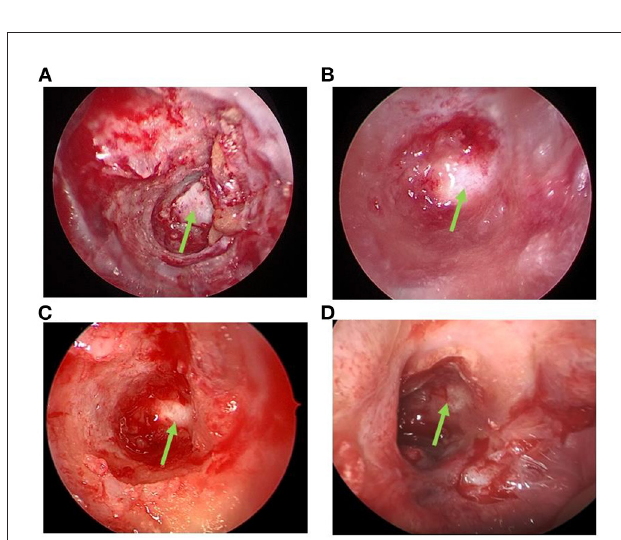
FIGURE2 Green arrow: The optic nerve. (A) Immediately after decompression: The optic nerve was exposed, and the decompression was sufficient. (B) After dressing change 1 week after surgery: Sphenoid sinus and ethmoid sinus were cleaned, secretion was removed by suction, nasopore was filled beside the optic nerve, and 30 µ g NGF + 1mL triamcinolone acetonide was injected. (C) After dressing change 3 weeks post-surgery. (D) After the dressing change 5 week post-surgery, there was no secretion in the sinus cavity, and the mucosa was